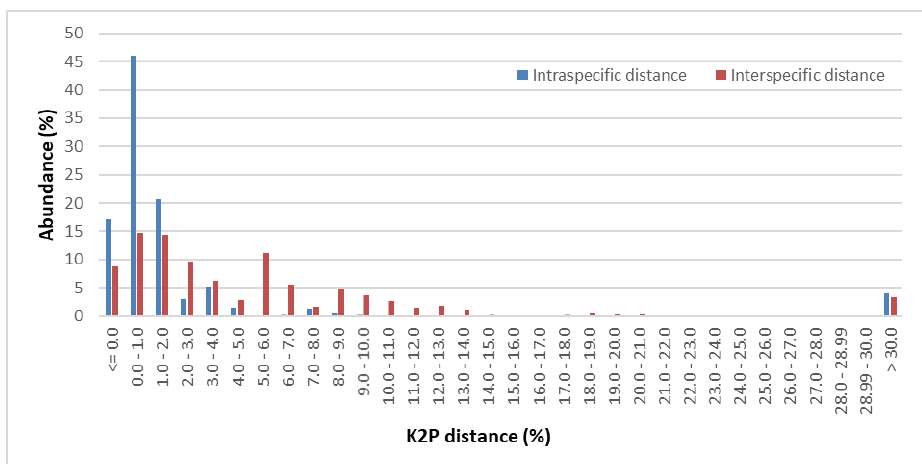
Figure 1. Abundance of all intraspecific and all interspecific K2P pairwise distance in Pinaceae.